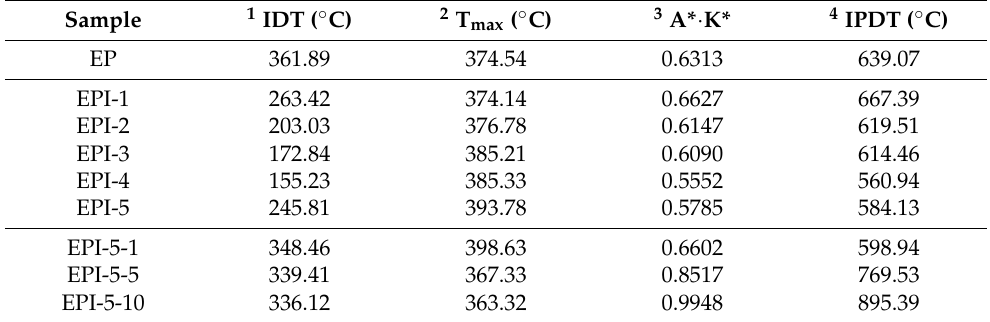
Table 4. Thermal parameters of postcured epoxy/polyimide blends analyzed in N 2 gas atmosphere. Sample